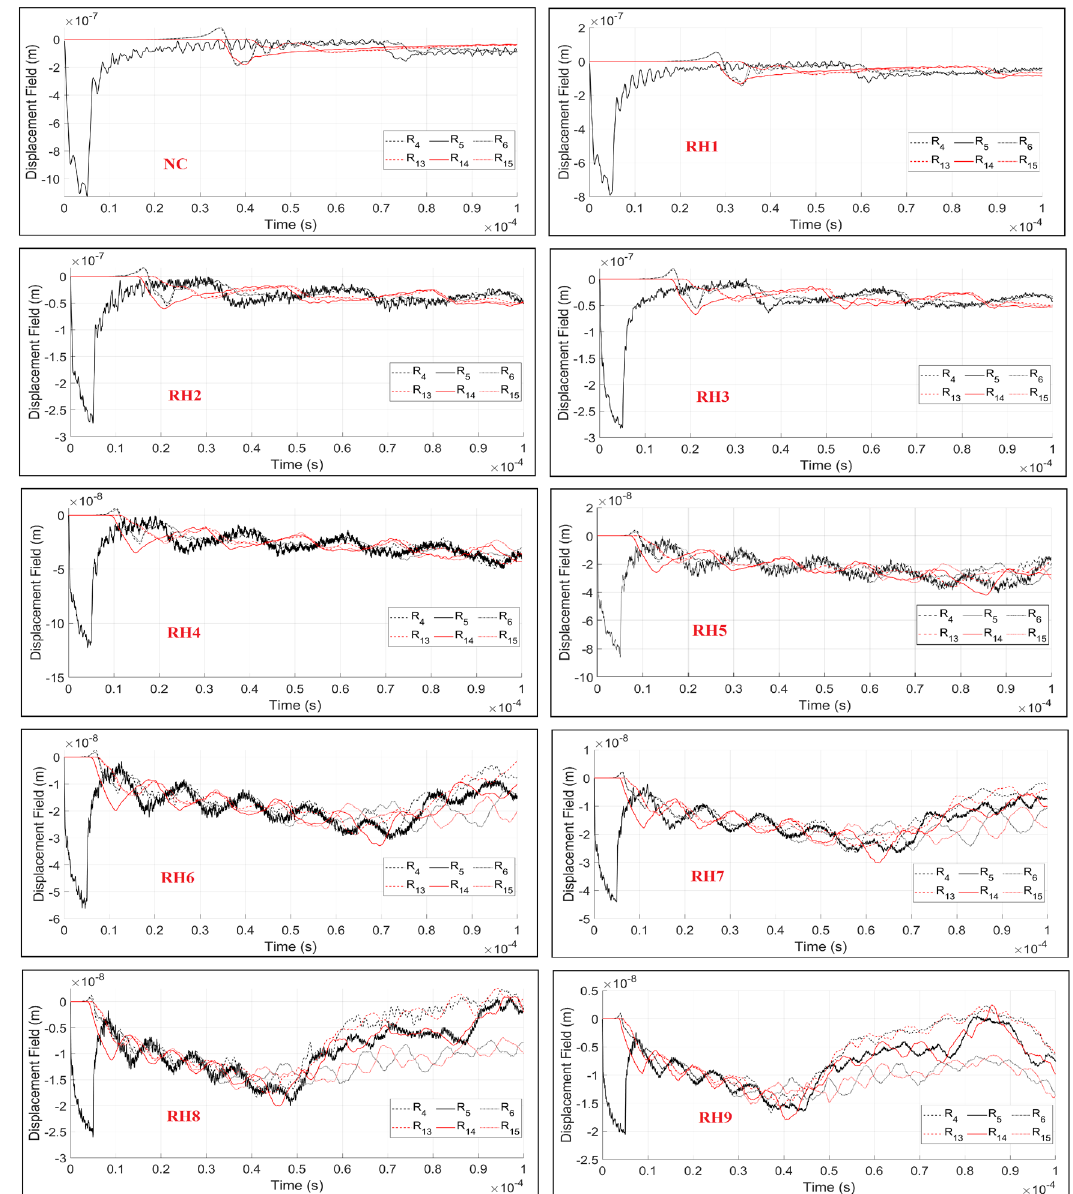
Figure 18. The recorded time histories at the receiver sensors ( R i ) under consideration of different heterogeneity ratios in rock domain: NC,